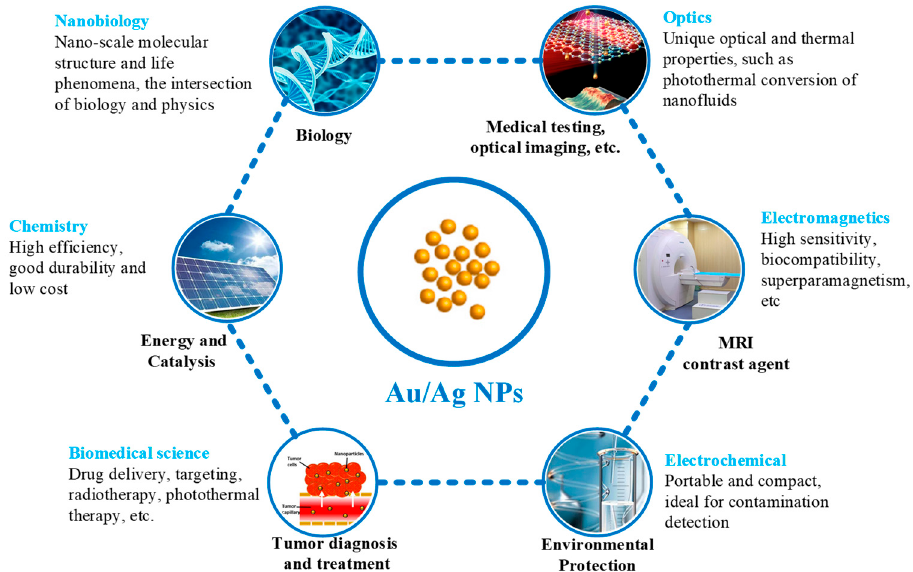
Figure 1. Properties and application of Au/Ag NPs in different fields.